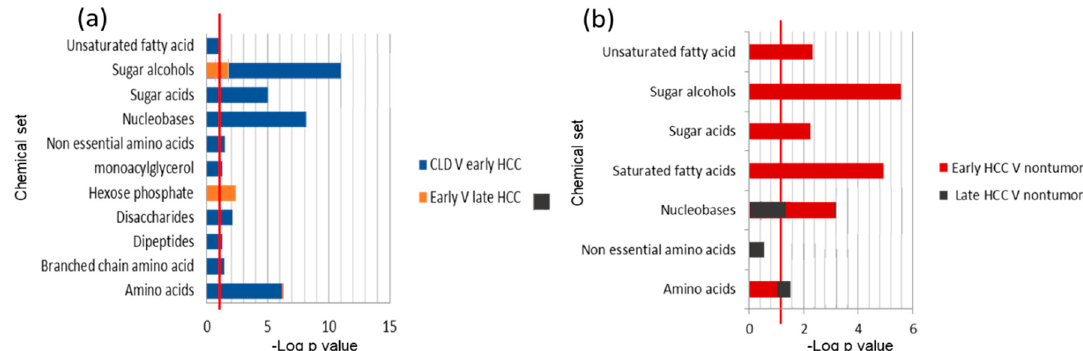
Figure 7. ChemRICH set enrichment statistics comparison for blood ( a ) and HCC tissues metabolites ( b ). ( a ) Significant chemical sets in blood metabolites for early HCC patients versus CLD subjects (blue) and comparing early-stage HCC versus late-stage HCC (orange). ( b ) Significant chemical sets in HCC tumor metabolites to paired non-malignant liver tissues for early HCC stages (red) and late HCC stages (black). The set enrichment significance level of p < 0.05 ( − log p = 1.3) is indicated by red lines.